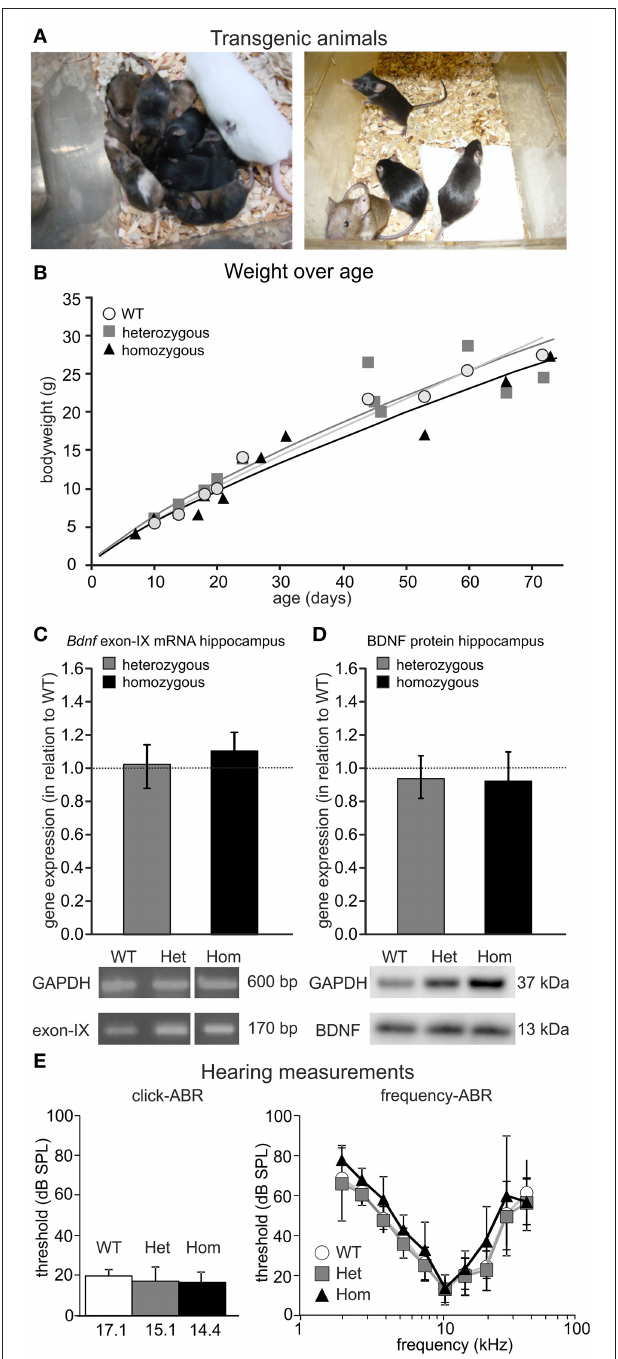
FIGURE 4 | Phenotype of the BLEV mouse line. (A) Heterozygous BLEV mouse (white; left panel) and adult homozygous animals (right panel). (B) Comparison of the weight of the different genotypes (WT; het; hom). Individual symbols represent individual animals (WT n = 9, Het n = 11, Hom n = 11 animals). (C) Analysis of Bdnf exon-IX mRNA expression by RT-PCR in the hippocampus of BLEV mice for WT, heterozygous and homozygous animals. BDNF expression was normalized to the WT expression level (dotted line). No changes in the expression of untranslated Bdnf exons (I, II, III, IV, VI, IXA) were